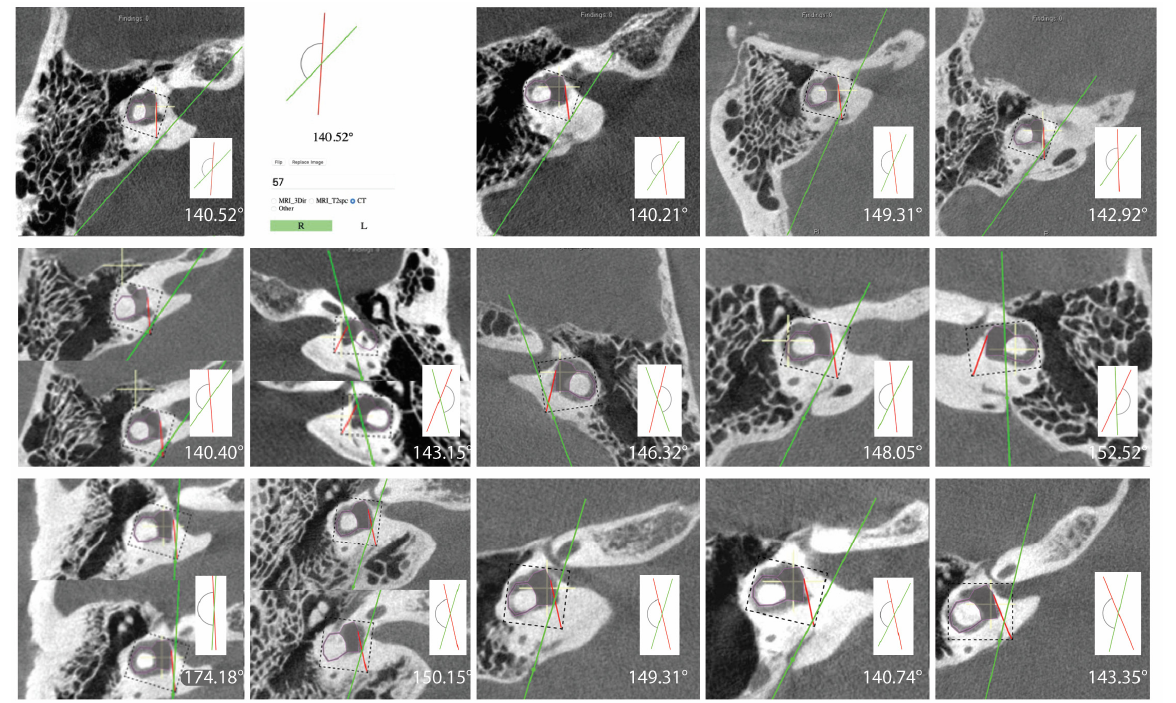
Figure 2. Images and measurements for all ears with ATVA > 140 degrees are shown. Bächinger et al. software used to measure the ATVA [1]. Some ears use two images to calculate the angle. If the vestibular aqueduct and the vestibule are not visible in a single plane, the software provides an option to use both an image at the level of the vestibule and another image at the level of the distal VA to measure a exit .